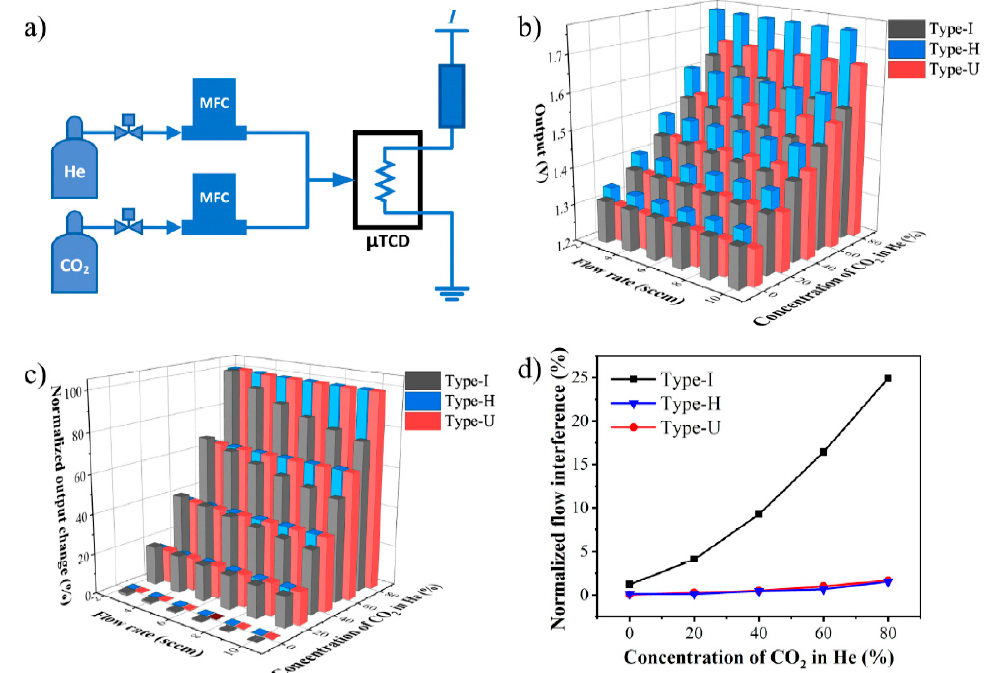
Figure 6. The experiment of changes in gas flow rate and concentration simultaneously. ( a ) The test platform, ( b ) the output of the devices, ( c ) the normalized output change, ( d ) the normalized flow interference under different gas conditions.